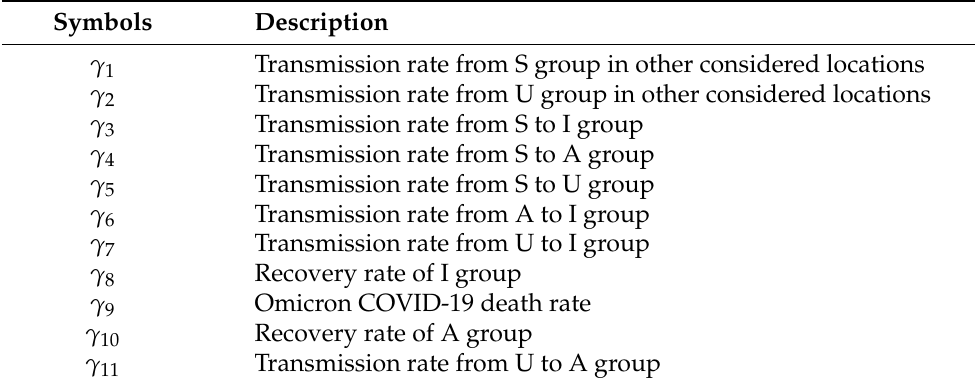
Table 1. Definition of the